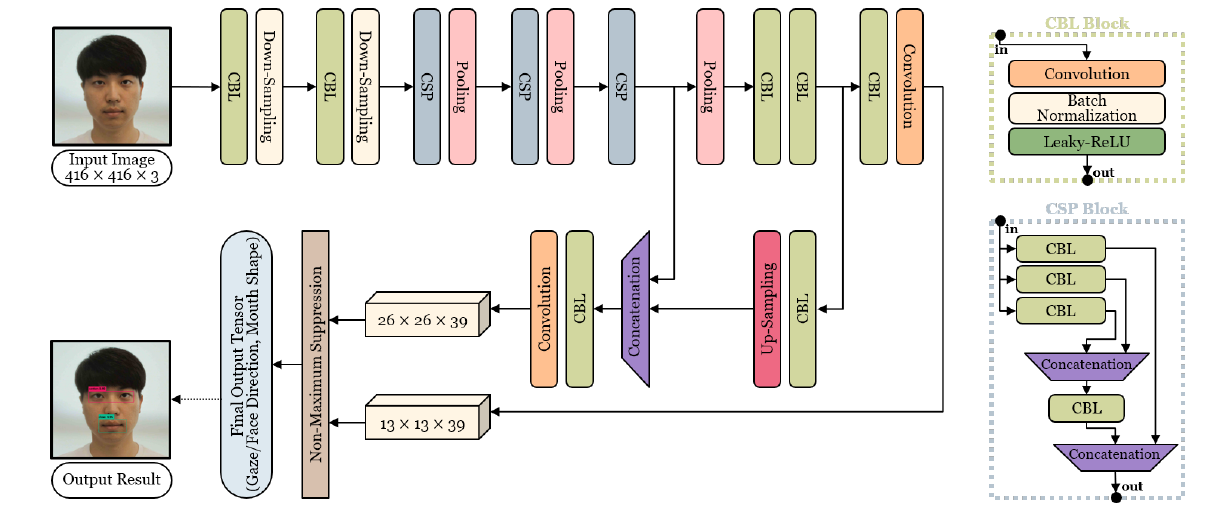
Figure 10. A CNN model architecture for face